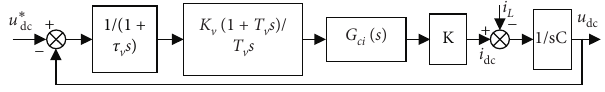
Figure 9: The control diagram of voltage closed loop.